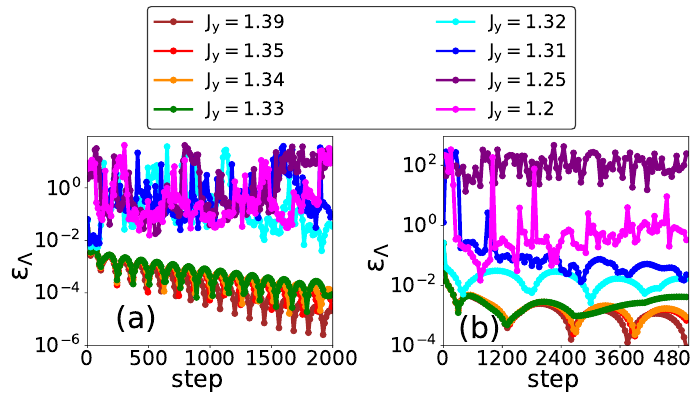
Figure 4: The evolution of ε Λ at selected values of J = 1.4 (where a steady state exists) to J sweep from J y and using timesteps (a) δ t = 10 − 2 , (b) δ t = 10 − 3 . All other parameters are the same as in Fig. 1. Energies given in units of κ =